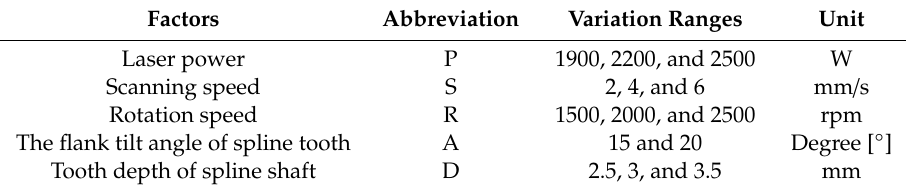
Table 3. Factors used in the experimental tests and range of